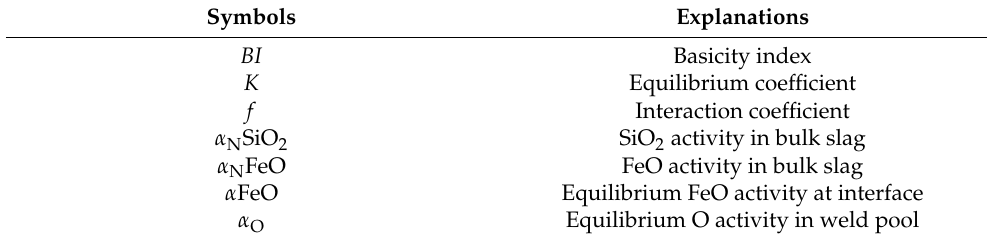
Table 6. List of